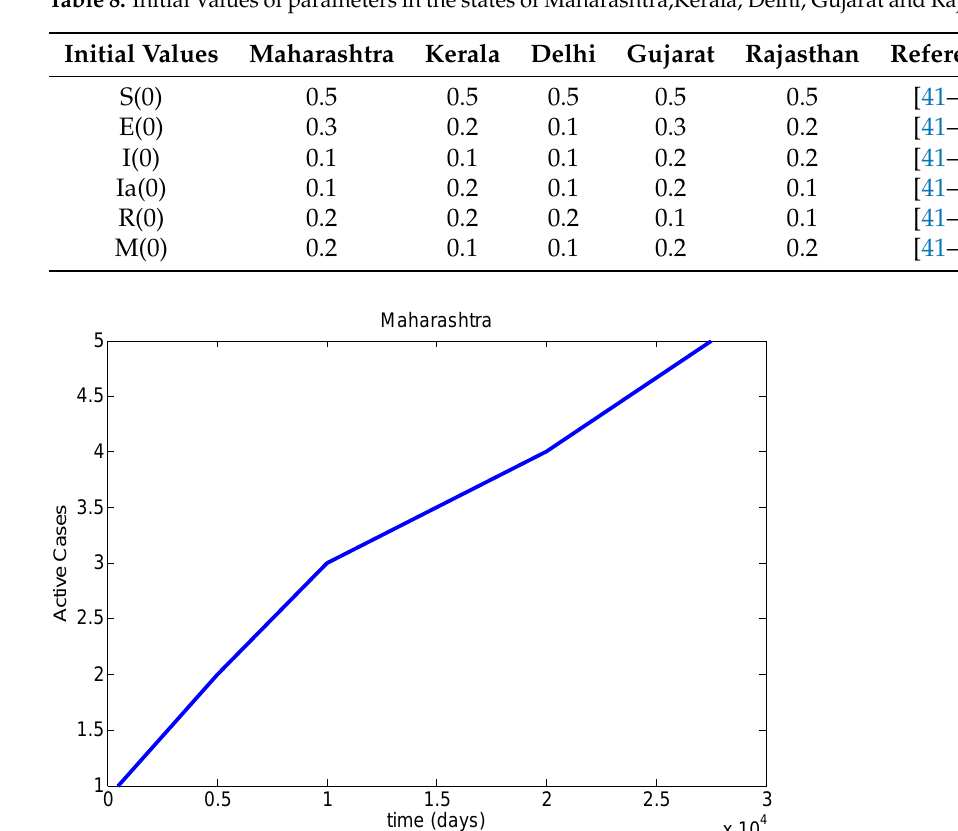
Fig. 7 Active cases of Maharshtra from real life data